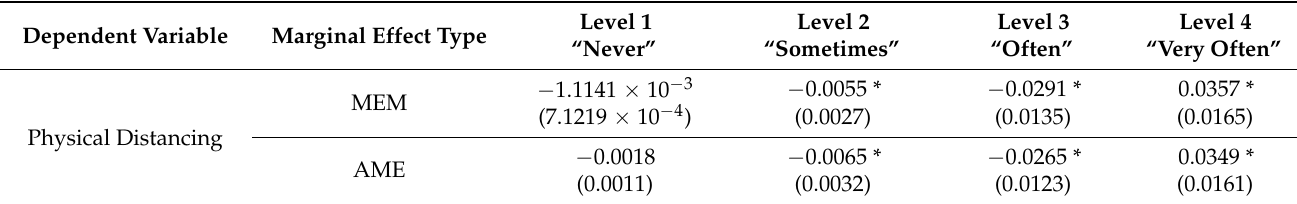
Table 9. Marginal effects of the MAAS scores on physical distancing.